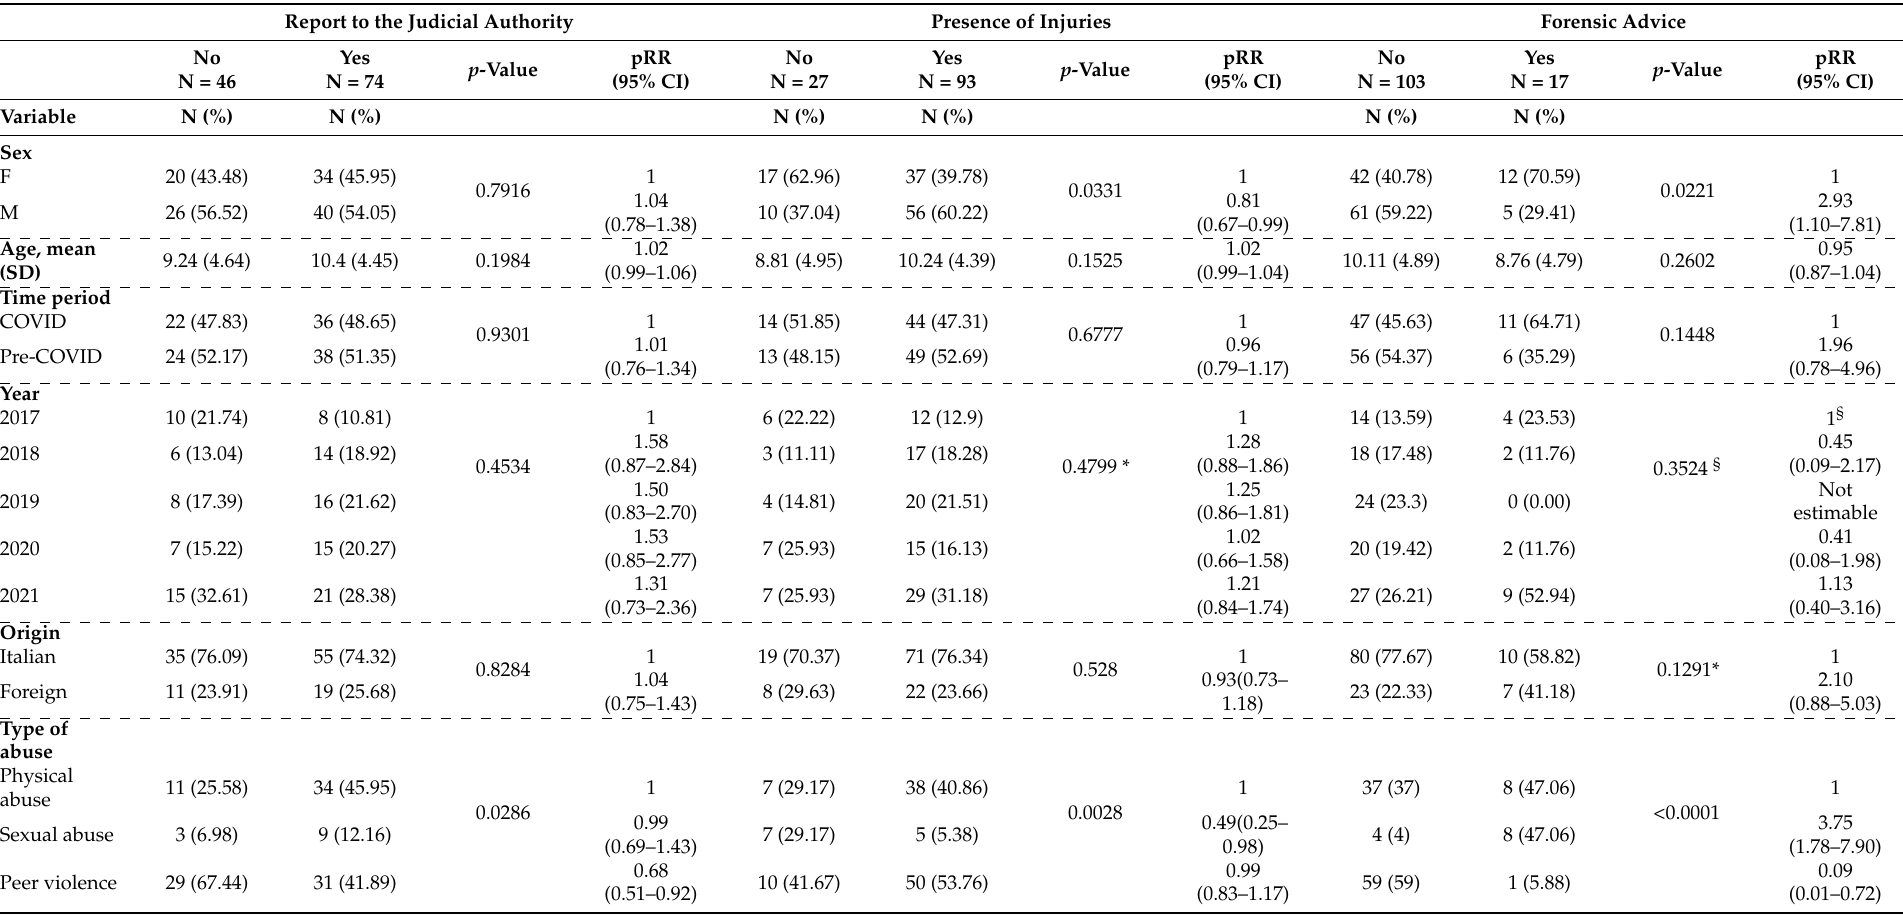
Table 2. Distribution of subject’s characteristics according to the event, p -value of the association test, pRR and corresponding 95%